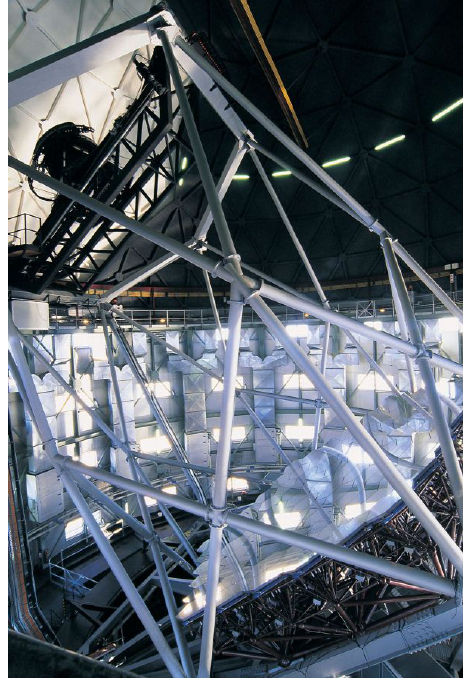
Figure 1: The 11-m Southern African Large Telescope (SALT), consisting of 91 × 1.2 m (corner-to-corner) hexagonal mirror segments.